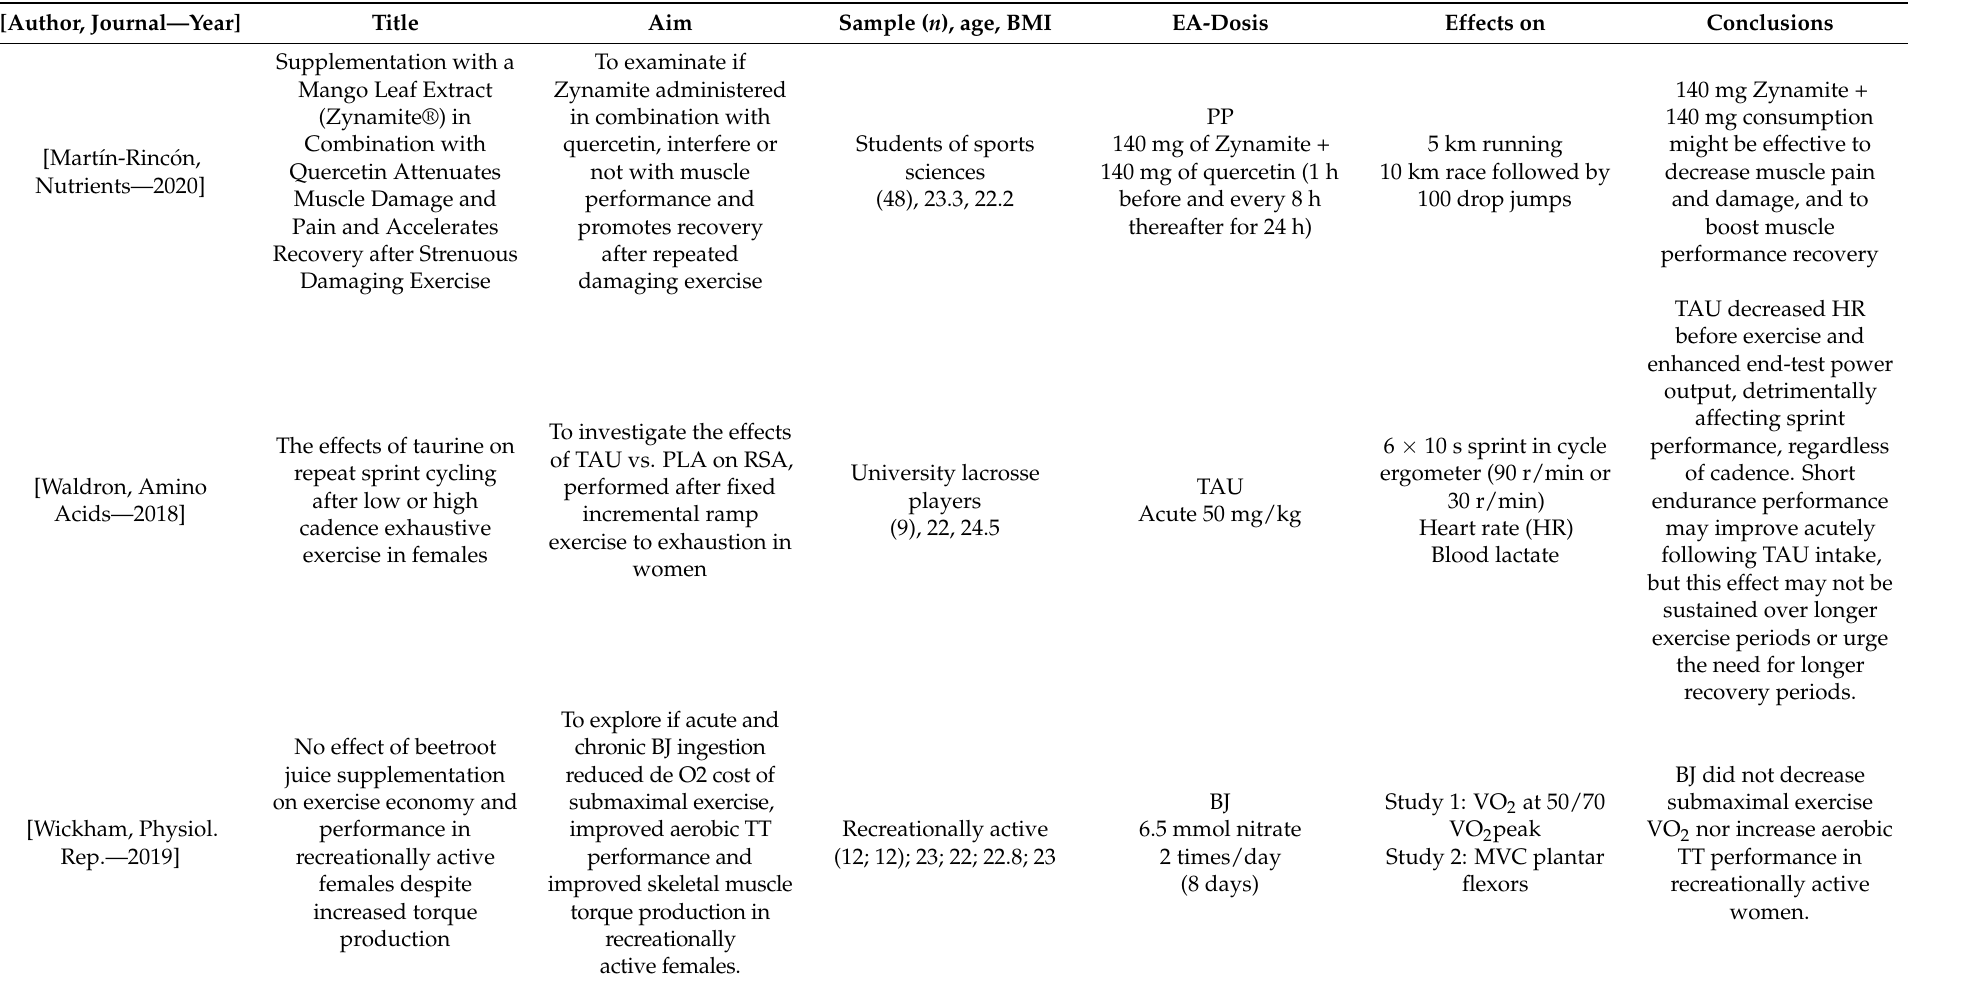
Table 1. Characteristics of the studies included in the systematic